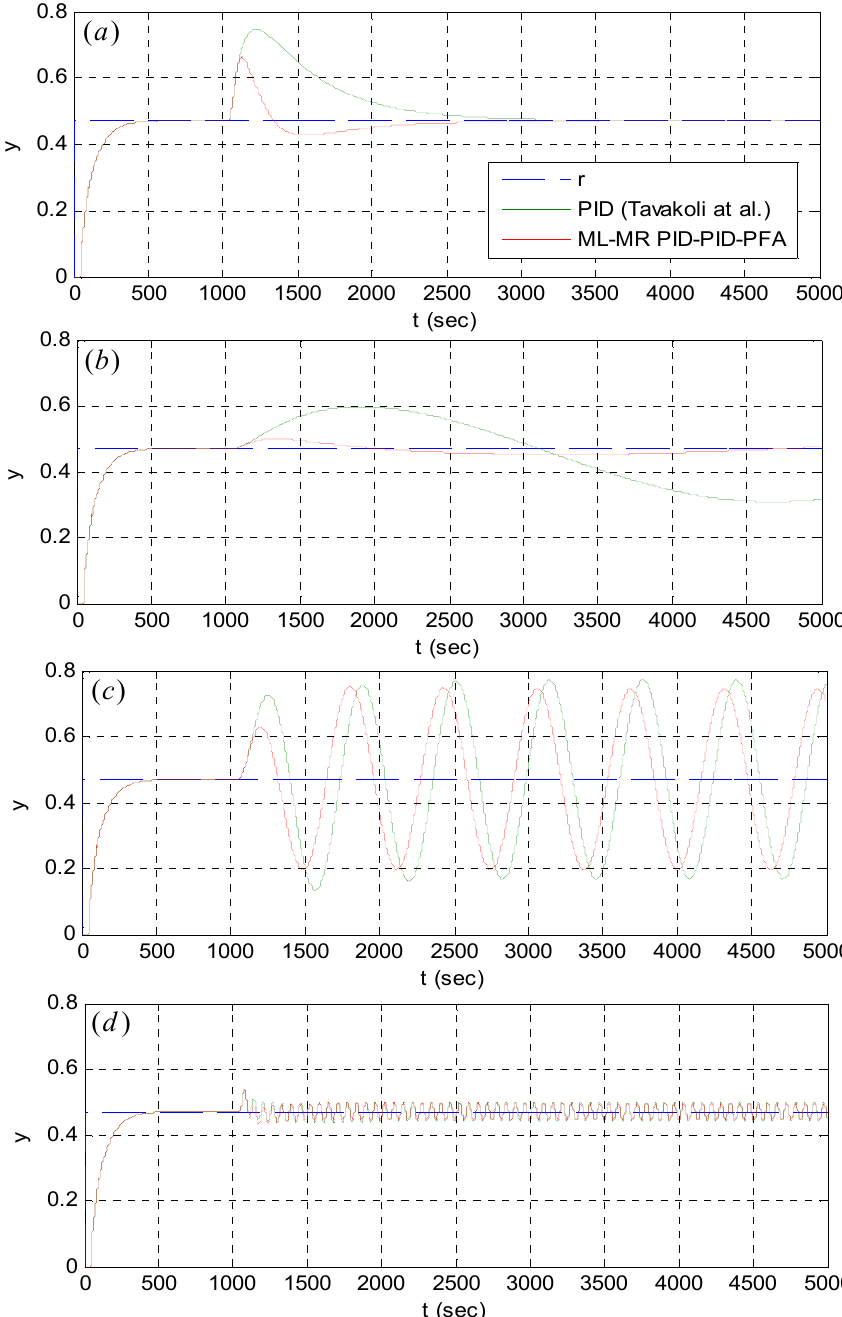
Figure 18. Comparisons of disturbance rejection performances of classical PID control and ML-MR PID-PID-PFA control structures for ( a ) step disturbance, ( b ) sinusoidal disturbance with a frequency of 0.001 rad/s, ( c ) sinusoidal disturbance with a frequency of 0.01 rad/s, and ( d ) sinusoidal disturbance with a frequency of 0.1 rad/s.